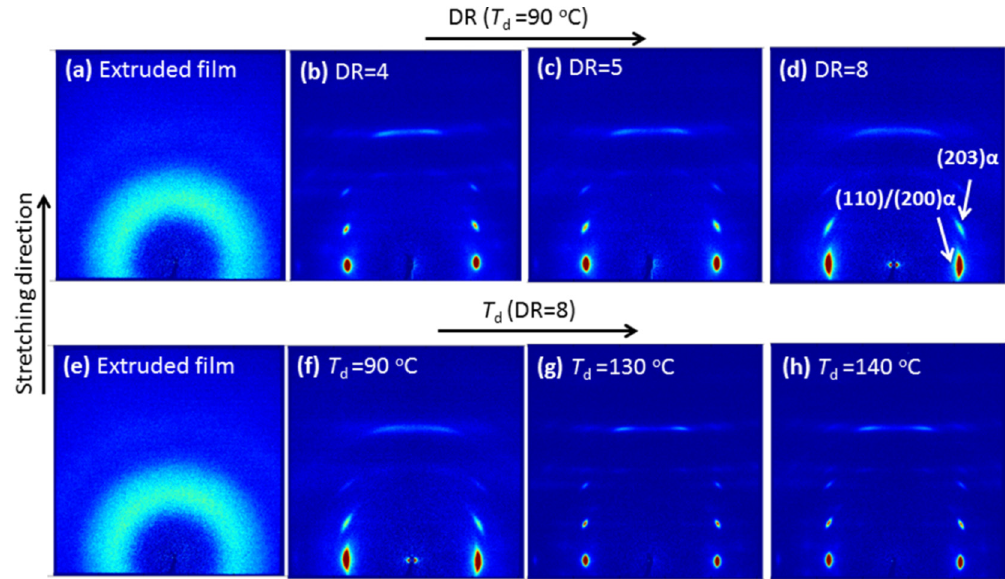
Figure 7. 2D WAXS patterns of ( a , e ) as-extruded tapes, tapes drawn at 90 °C to DR of ( b ) 4; ( c ) 5 and ( d , f ) 8; and PLLA tapes drawn at ( g ) 130 °C ( DR = 8) and ( h ) 140 °C ( DR = 8).The patterns were recorded with the incident beam perpendicular to the